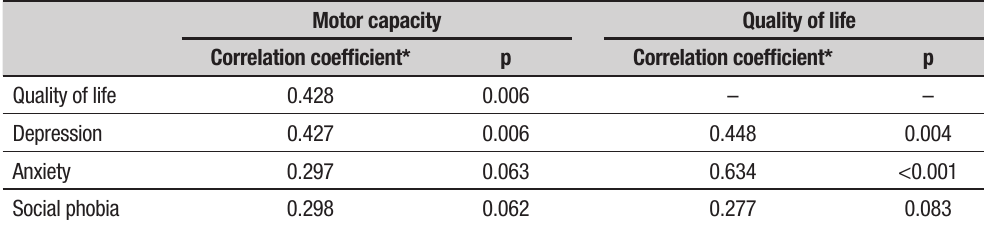
Table 3. Correlations between